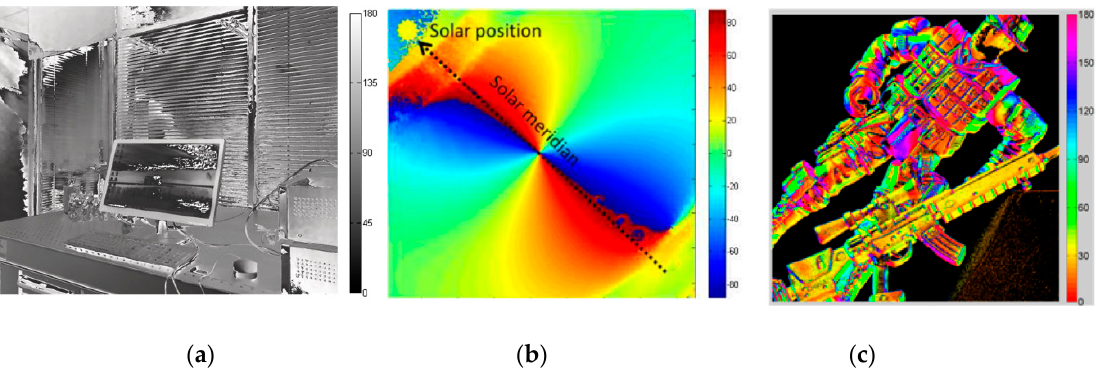
Figure 1. The results of previous AoP data visualization method: ( a ) Method 1 [19] ; ( b ) Method 2 [24] ; ( c ) Method 3 [25] .